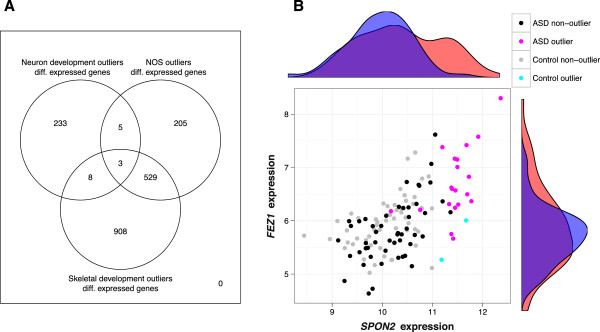
TGen outlier-group differentially expressed genes (Figure 4, step 5). Differential expression was calculated using t-tests on log (base 2) expression values at FDR < 5%. A) Overlap of differentially expressed genes for the three outlier groups. B) Comparison of the log (base 2) expression levels of the two most differentially expressed genes in the neuron development pathway, SPON2 and FEZ1. Marginal density plots show the distributions of case (red) and control (blue) samples.